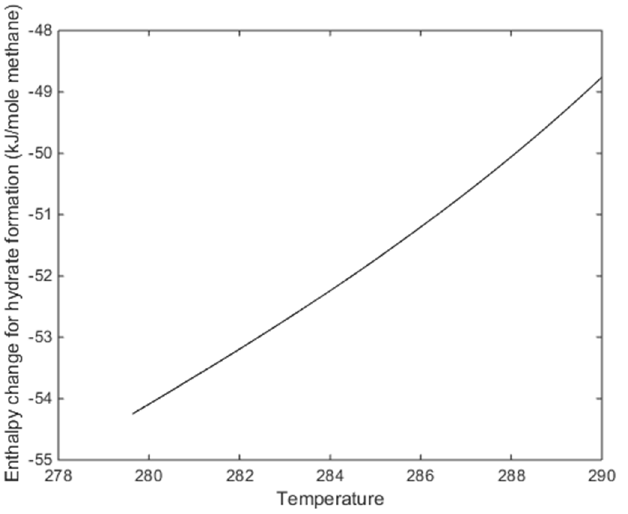
Figure 11. Enthalpy change for hydrate formation along the same range of the temperature pressure stability limits as in Figure 10.